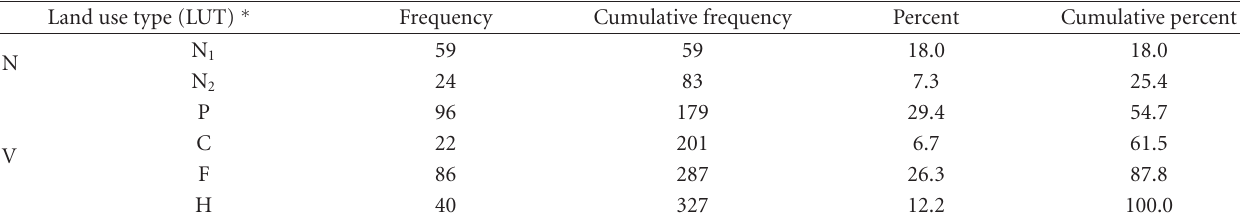
Table 5: Distribution of soil profiles of the Bras d’Henri watershed training dataset according to land use type (LUT) derived from a supervised maximum likelihood classification of the ASTER